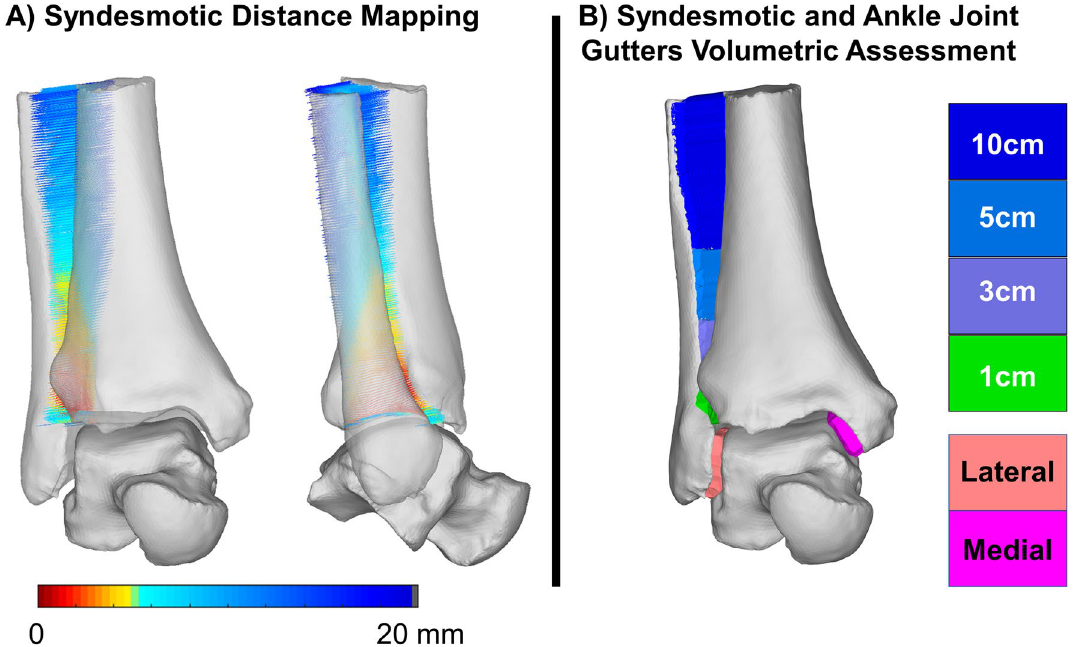
Figure 1. Distal tibiofibular syndesmotic joint distance mapping ( A ) and volumetric analyses ( B ). Distance maps were created (Disior Ltd, Bonelogic 1.0, Helsinki, Finland, https:// www. disior. com/ ortho- foot- and- ankle) along the averaged normal directions between the interfacing regions of the distal tibia and fibula ( A ). The bounded volume of these interactions (Matlab, MATLAB 2019a, MathWorks, Massachusetts, USA, https:// www. mathw orks. com) was automatically measured at 4 levels (1, 3, 5 and 10 cm proximally to the ankle joint) and are shown in colors from green to dark blue with the medial and lateral gutters in pink and red, respectively ( B